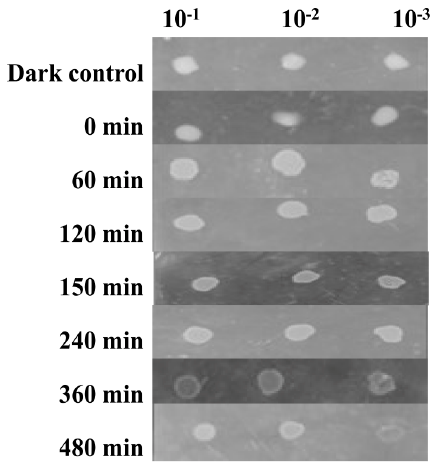
Figure 4. Screening of resistance to UV radiation: Growth and survival of Salinivibrio sp. HTSP monitored after exposing to UV for different time points.